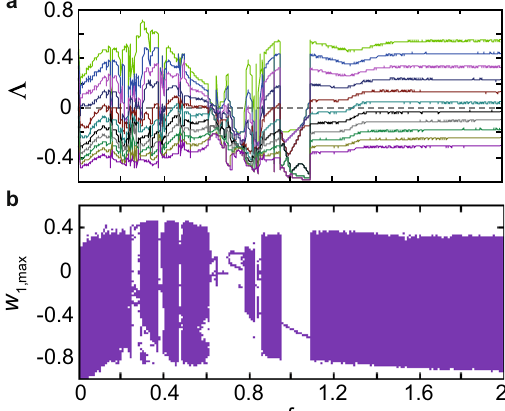
Fig. 6 Chaos control. a Conditional Lyapunov exponents spectrum and b bifurcation diagram for a ring of 15 qubits by means of an external parametric effect for Ω m = 2.5, c = 5, Δ = 5.0, M =